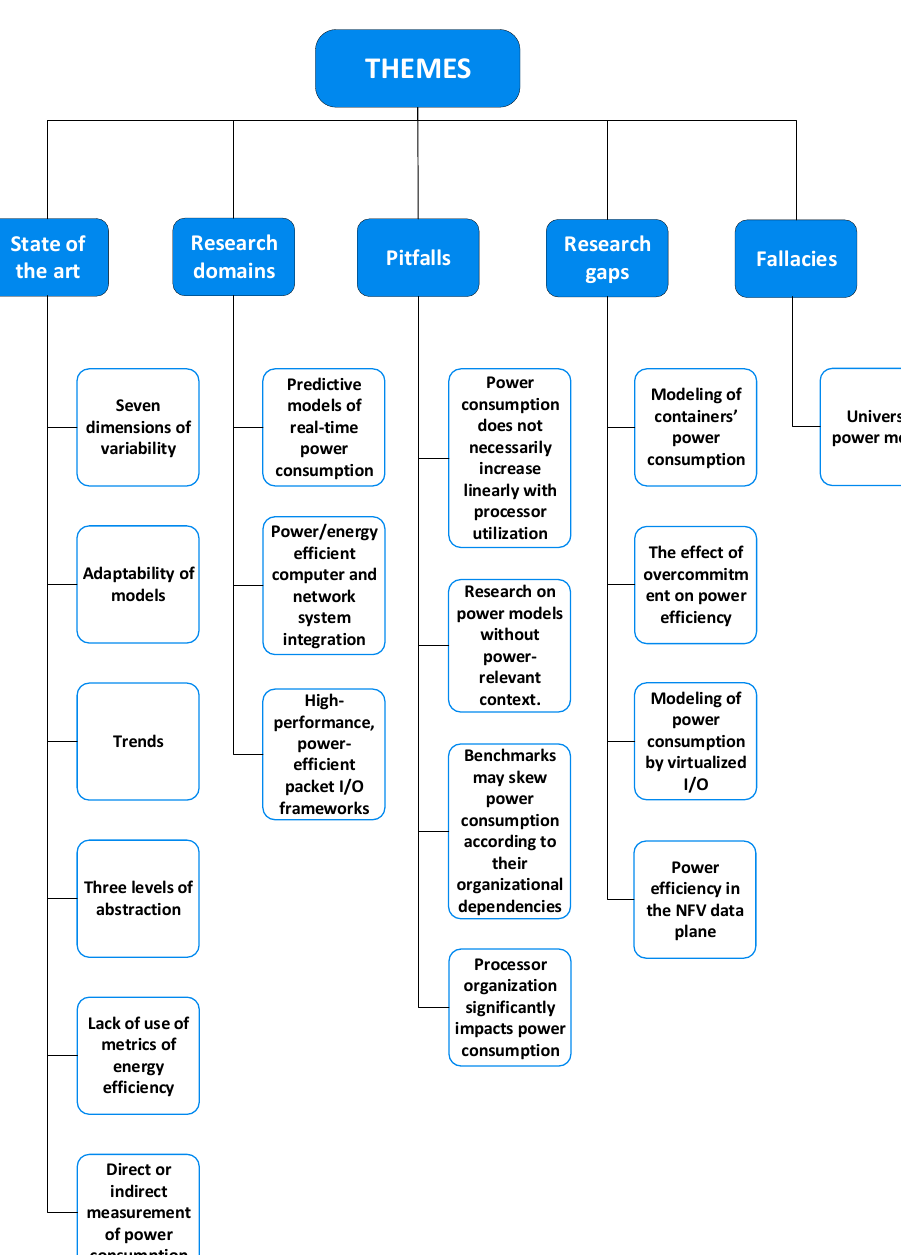
Figure 23. A graphical overview of the thematic analysis of the research space.